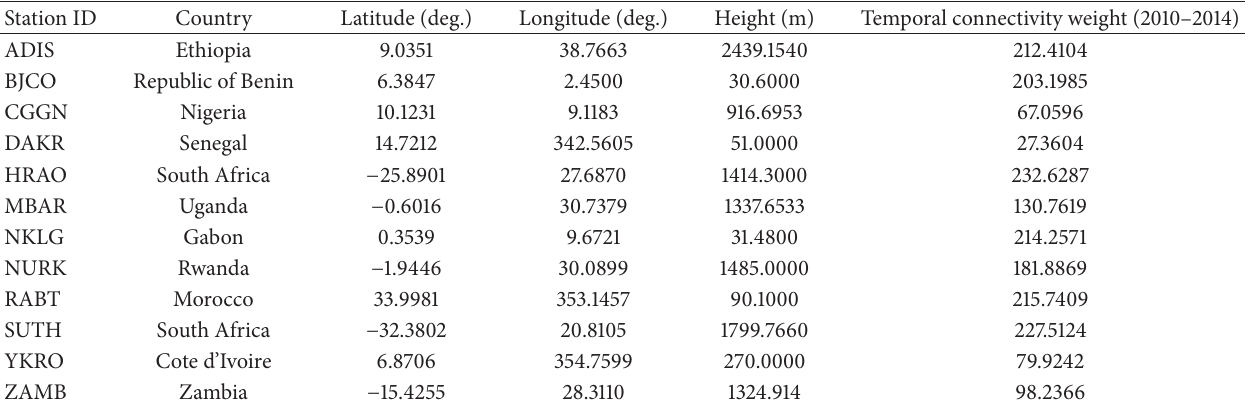
Table 4: GNSS sites and associated temporal